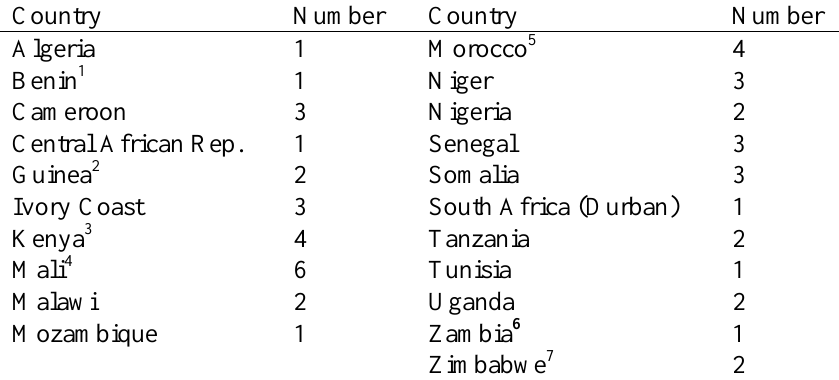
Table 4: African Social Forums-National, Sub-national and Local Country Number Country Number Algeria 1 Morocco 5 4 Benin 1 1 Niger 3 Cameroon 3 Nigeria 2 Central African Rep. 1 Senegal 3 Guinea 2 2 Somalia 3 Ivory Coast 3 South Africa (Durban) 1 Kenya 3 4 Tanzania 2 Mali 4 6 Tunisia 1 Malawi 2 Uganda 2 Mozambique 1 Zambia 6 1 Zimbabwe 7